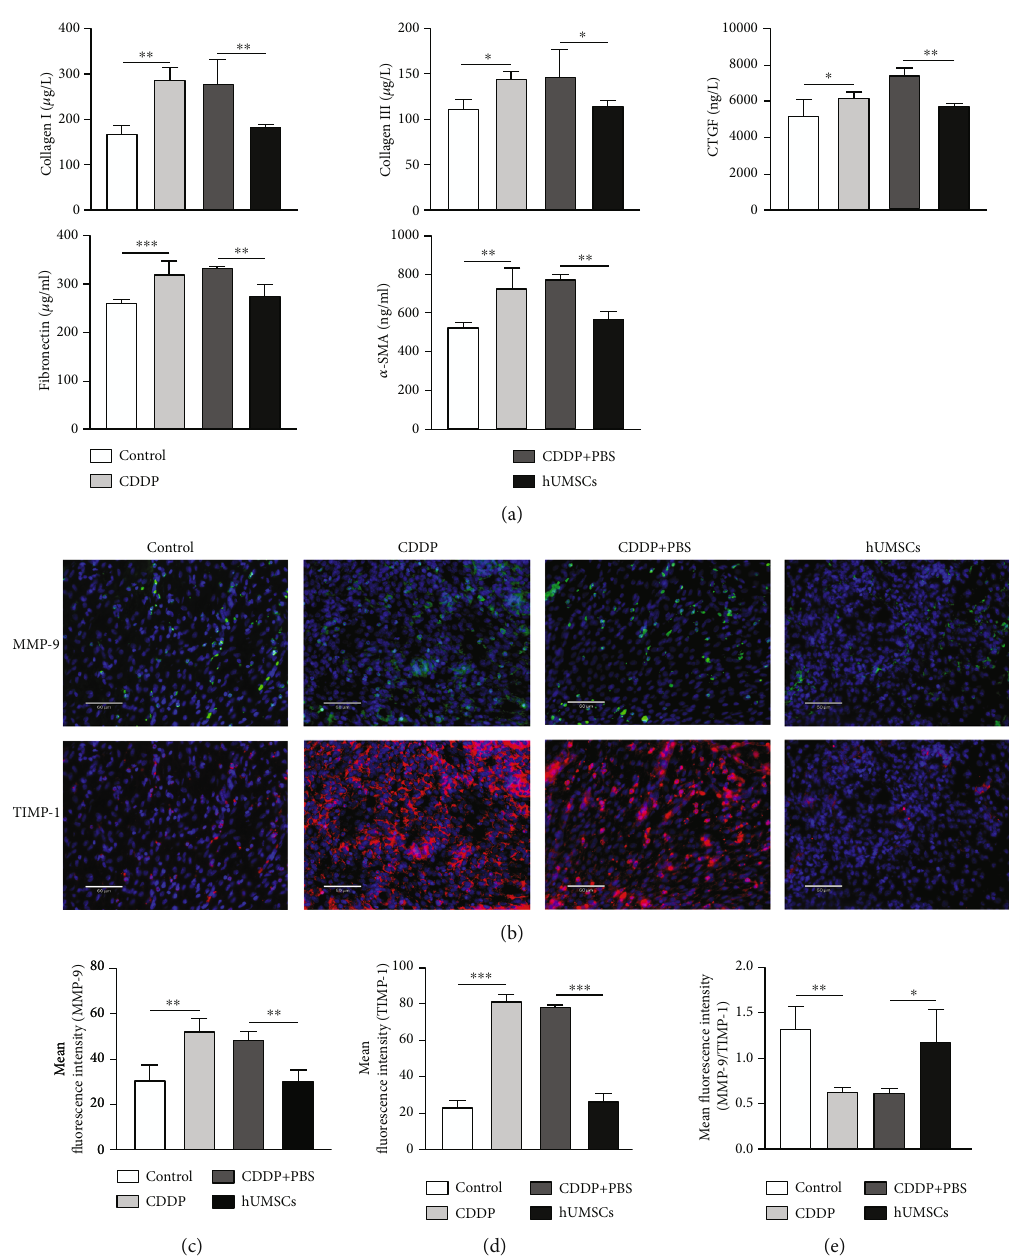
Figure 5: ELISA and immuno fl uorescent staining of uterine expressions of fi brosis-related, MMP-9, and TIMP-1 proteins. (a) Levels of Collagen I, Collagen III, CTGF, Fibronectin and α -SMA in each group. (b) Immuno fl uorescent staining of MMP-9 and TIMP-1 expressions in uterine tissues of each group (200x). (c – e) Mean fl uorescent intensities as analyzed by ImageJ software. Data are presented as the means ± SDs . ∗ P < 0 : 05, ∗∗ P < 0 : 01, and ∗∗∗ P < 0 : 001 . CDDP: cisplatin; Collagen I: Collagen Type I; Collagen III: Collagen Type III; CTGF: connective tissue growth factor; α -SMA: alpha smooth muscle actin; MMP-9: matrix metalloprotein 9; TIMP-1: tissue inhibitor of